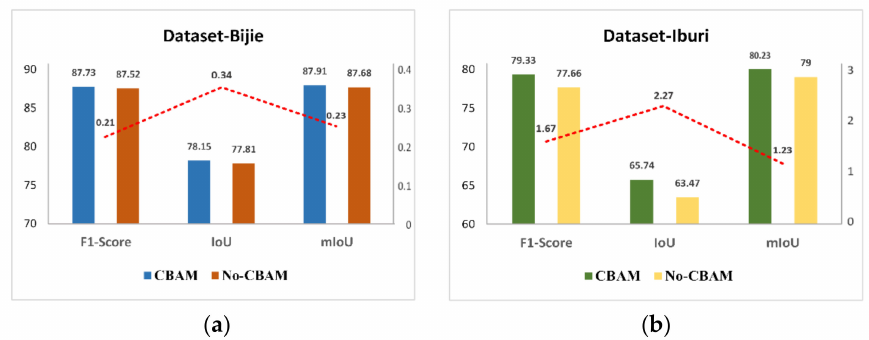
Figure 9. The performance and variation of the proposed model before and after embedding CBAM. ( a ) represents the Bijie dataset, ( b ) represents the Iburi dataset. The dashed line represents the increment after embedding CBAM.